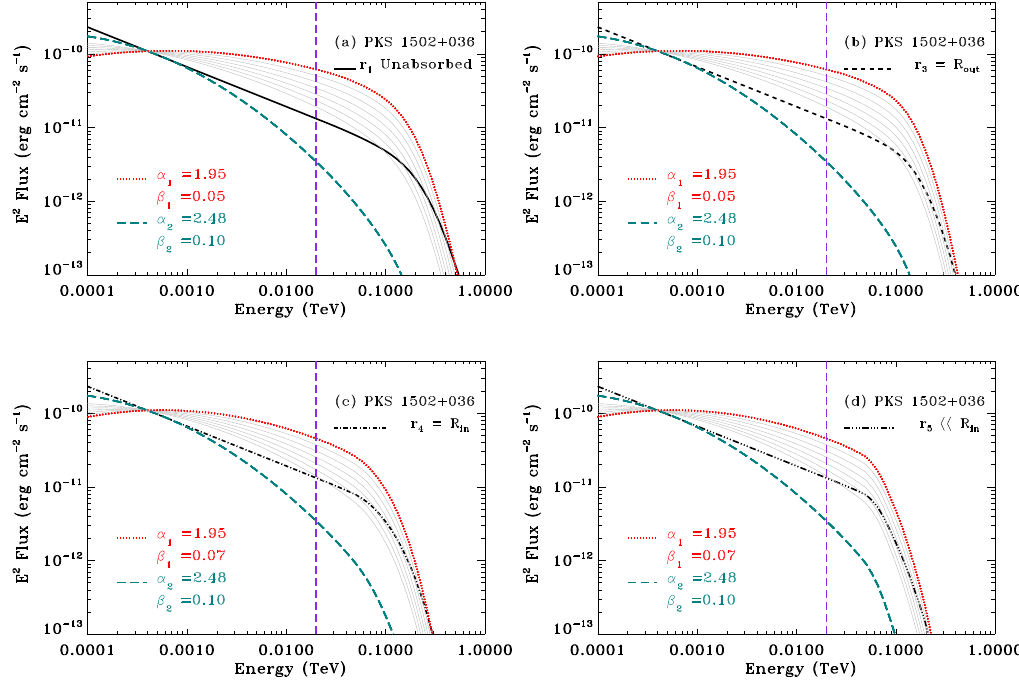
Figure 5. Spectral energy distribution in the energy range 100MeV–1TeV for PKS 1502 + 036. ( a ) R em = r 1 (cid:29) R BLR ; ( b ) R em = r 3 = R out ; ( c ) R em = r 4 = R in ; ( d ) R em = r 5 (cid:28) R in . The vertical purple dashed line at E = 20GeV represents the CTA energy lower